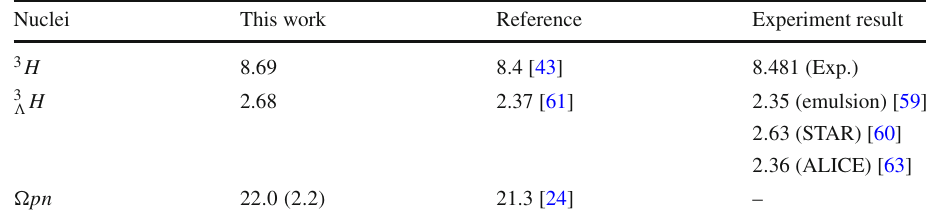
Fig. 1 Diagrams of three coordinate frames. From left to right, the coordinate is numbered as I, II and III, respectively, where c i (cid:20) M tot Q = − c i ( i , j , k = I ( 1 ), I I ( 2 ), I I I ( 3 ) and (cid:20) ijk = 1 . ) 2 M i M jk Table 3 The binding energies Nuclei This work Reference Experiment result of 3 H , 3 (cid:2) H and (cid:3) pn calculated by a variation method. Results of this work are consistent with other’s work and experimental results. The unit is in MeV